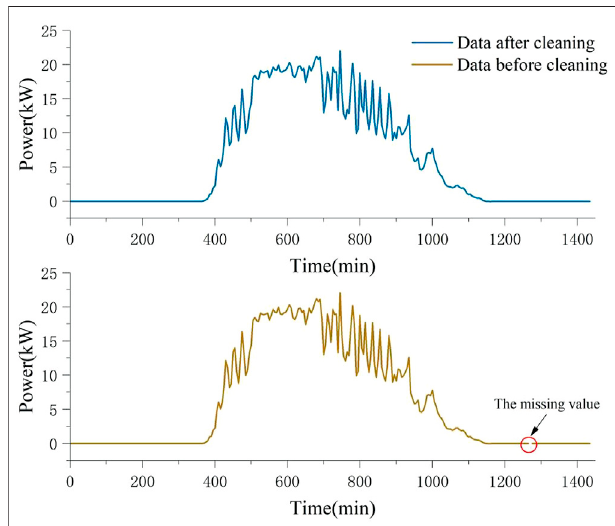
FIGURE 4 | The data before and after cleaning.